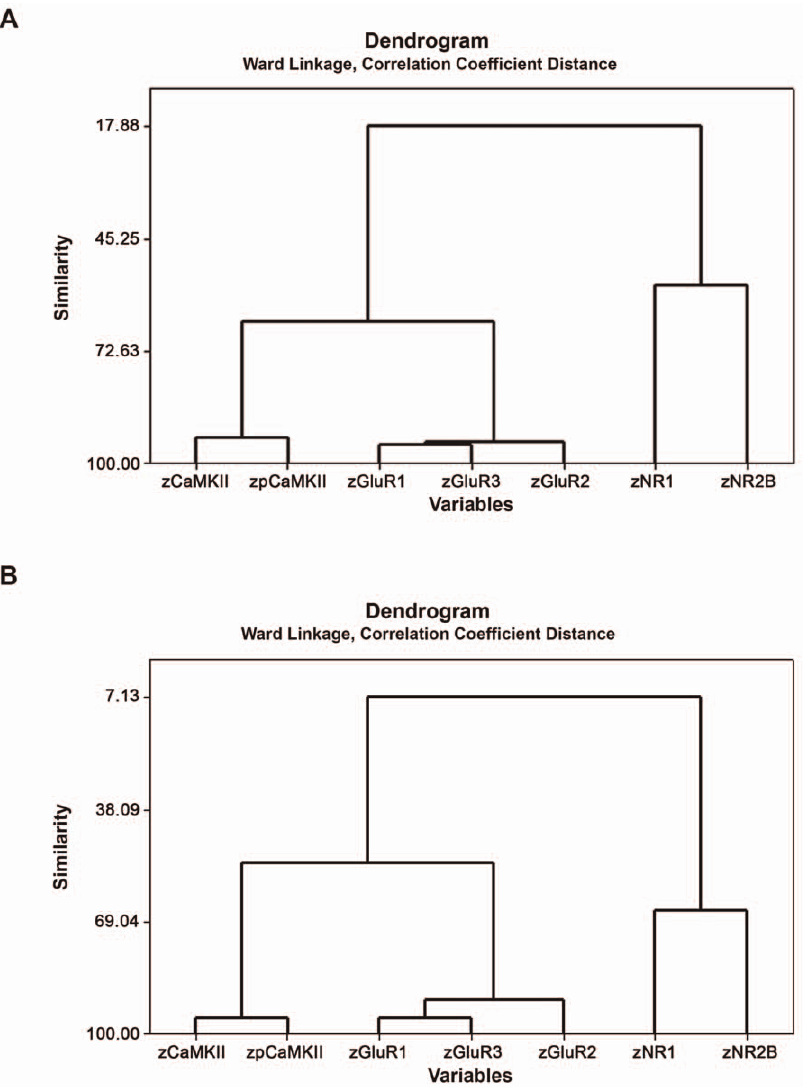
Figure 4. Cluster analysis, using the correlation coefficient distance and Ward’s minimal variance algorithm, on the neurochemical data at 6 months post-op. for the CA1, CA2/3 and the DG data together, showing the relationship between the different neurochemical variables as z scores (zCaMKII etc) for the sham (A) and BVD (B) animals. Note that there is no difference between the clusters for the sham and BVD